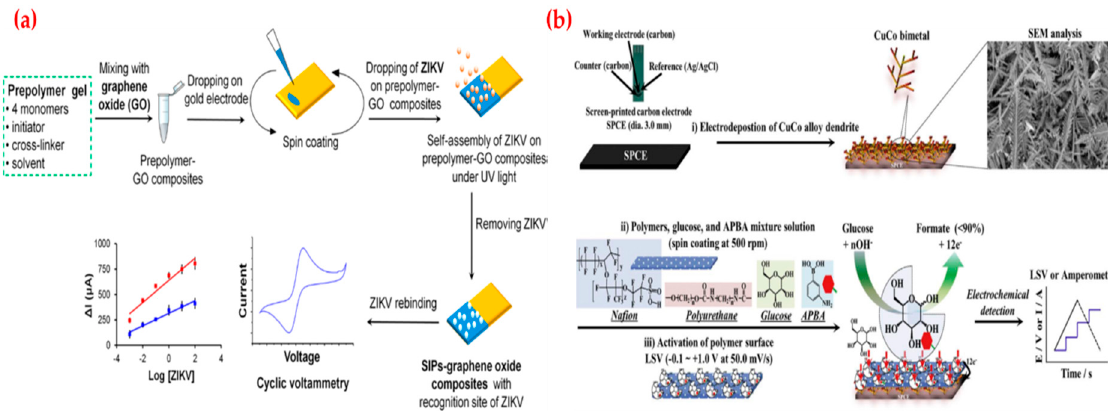
Figure 5. ( a ) Schematic representations of the virus-imprinted sensor and ( b ) glucose-imprinted sensor. Republished with permission from [115,116]; permission conveyed through the Copyright Clearance Center, Inc.